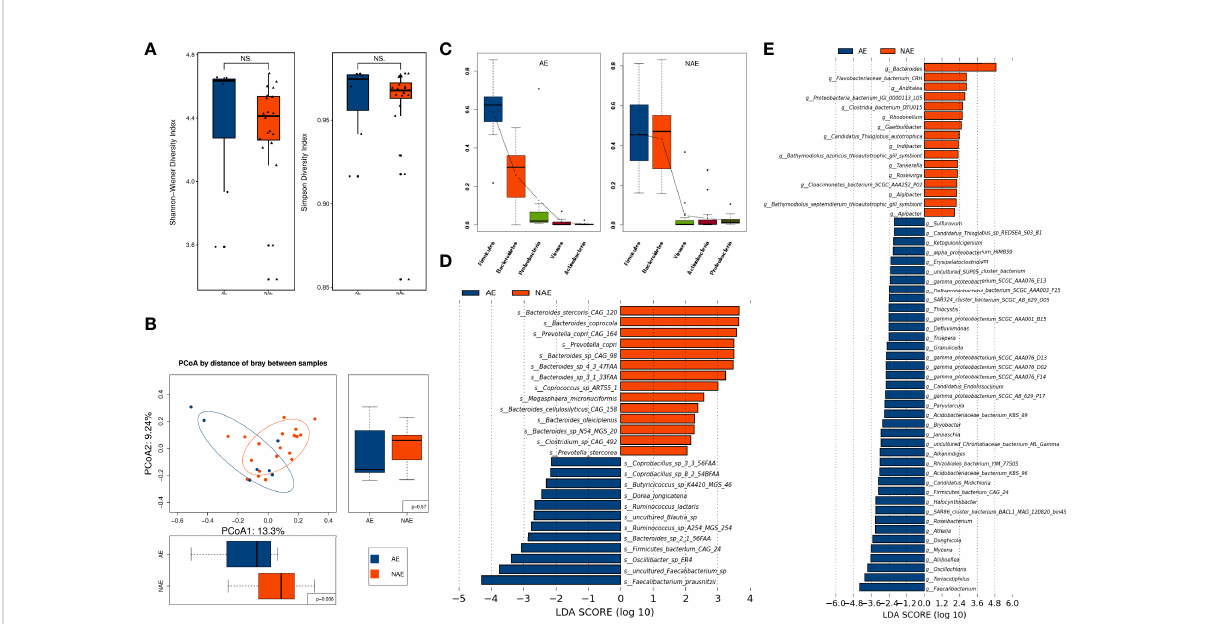
FIGURE 7 The correlation of the baseline gut microbiome and irAEs. (A) Alpha diversity was determined by the Shannon and Simpson indices at the species level between the AE group (n = 7) and the NAE group (n = 20). (B) Beta diversity was evaluated by PCoA analysis at the species